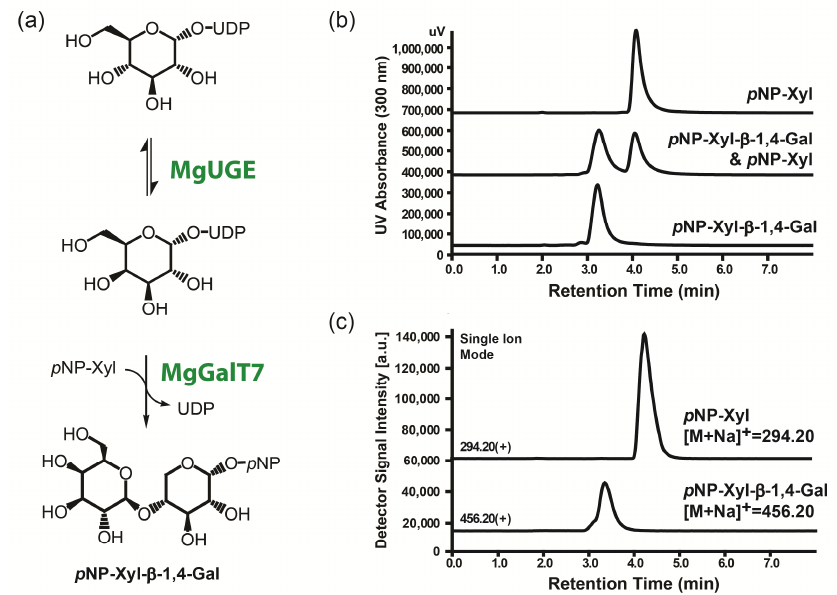
Figure 3. Enzymatic galactosylation reaction. ( a ) Schematic overview of the reaction cascade consisting of MgUGE and MgGalT7 using para -nitrophenol xylose ( p NP-xylose) and UDP-Glucose as substrates; and ( b ) HPLC and ( c ) mass spectrometric analyses of the acceptor substrate and the galactosylated reaction product.